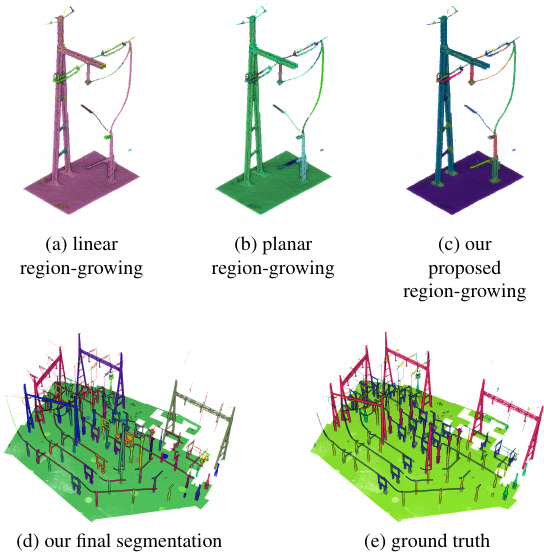
Figure 10. Comparison of two methods of region growing based respectively on the tangents (a) and on the normals (b) of the PCA and of the proposed region growing (c). Only our method is able to correctly differenciate cables, ground and steel beams. Comparison of the proposed segmentation (d) and of the ground truth (e). Table 1. Quantitative comparison of our descriptor against state of the art